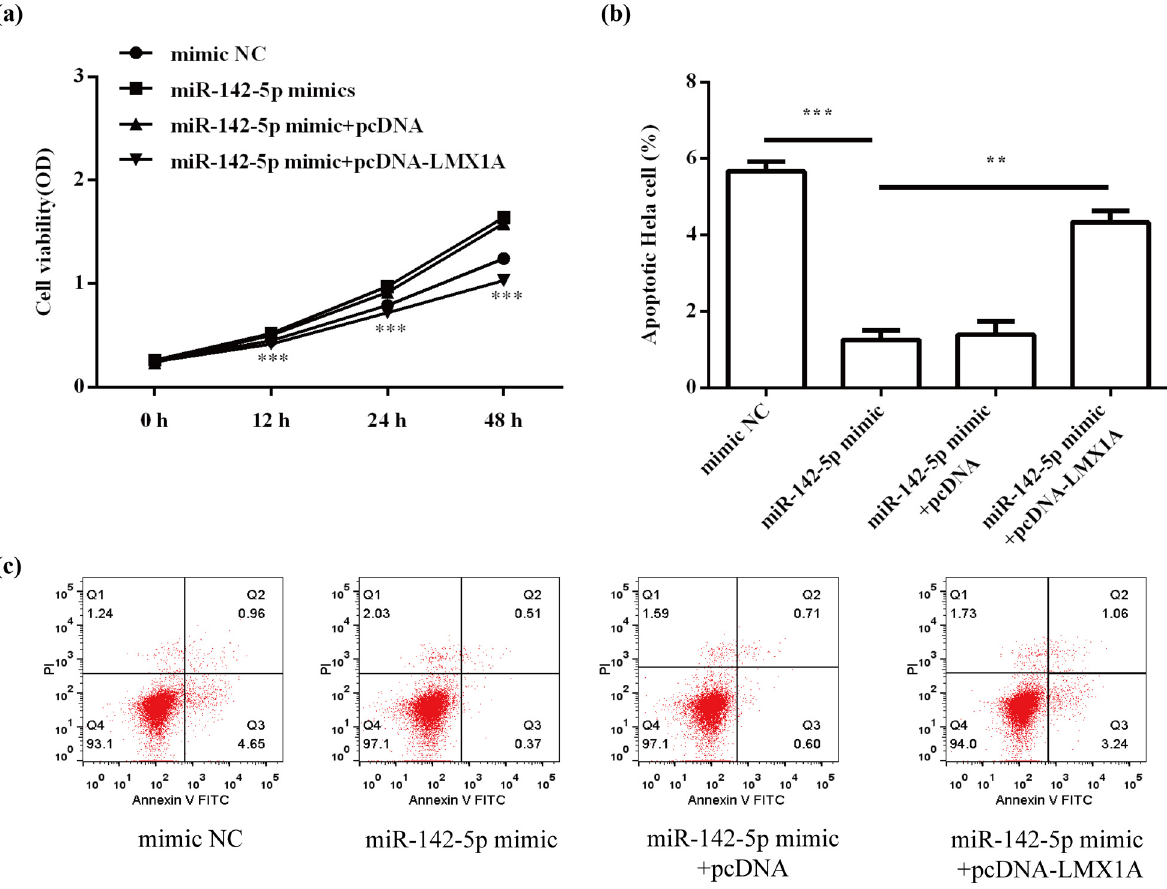
Figure 8: miR - 142 - 5p enhanced HeLa cell proliferation ( a ) and apoptosis ( b ) by targeting LMX1A. All experiments were performed in triplicate. ** P < 0.01. *** P <